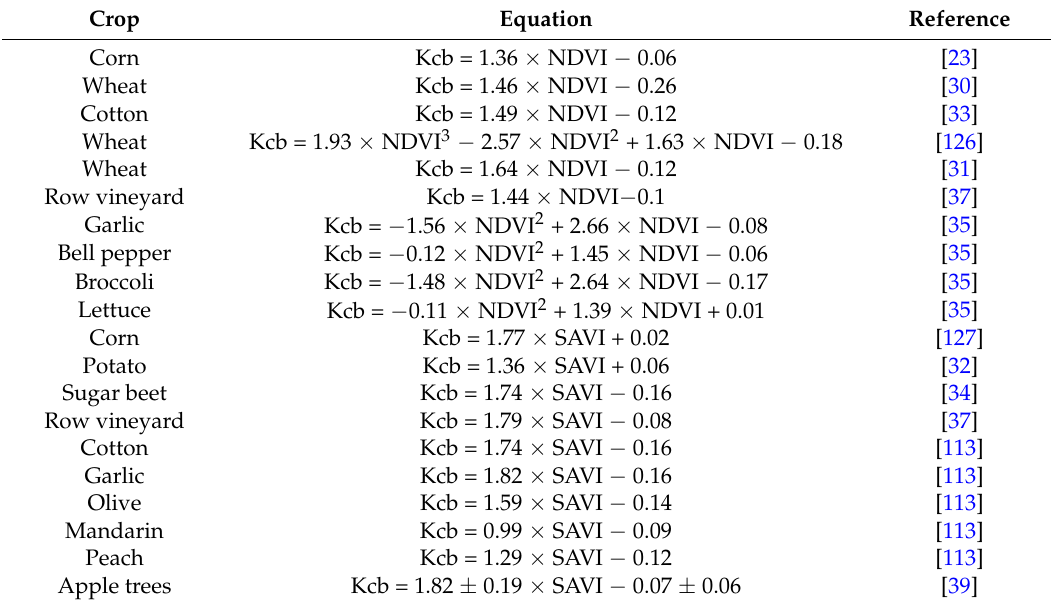
Table 1. Compilation of Kcb-VI relationships found in the